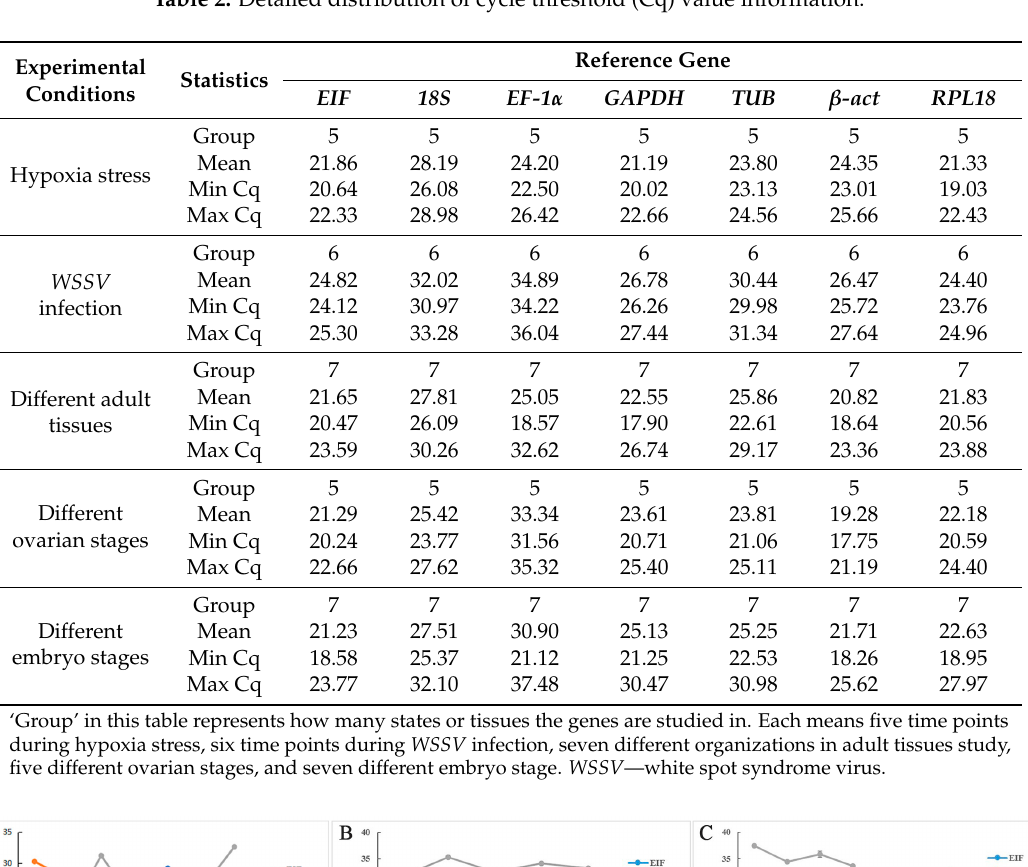
Table 2. Detailed distribution of cycle threshold (Cq) value information.